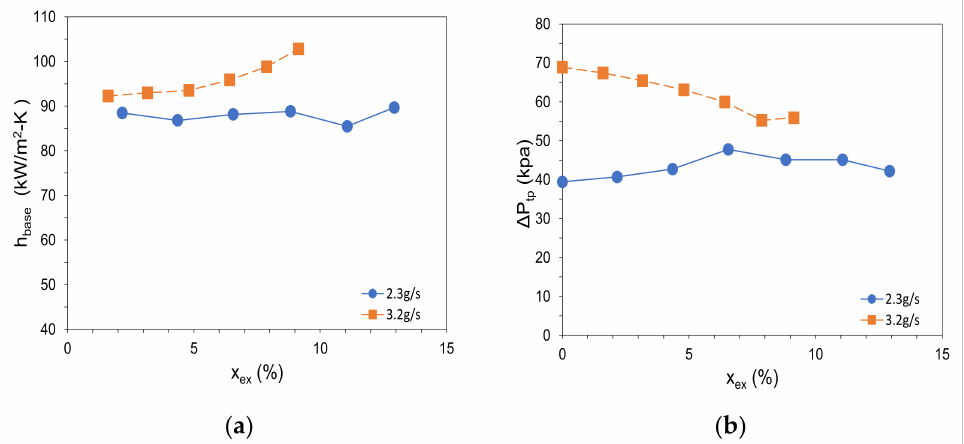
Figure 6. ( a ) Base heat transfer coefficient and ( b ) pressure drop of the cryogenic micro-gap cooler as a function of exit quality.